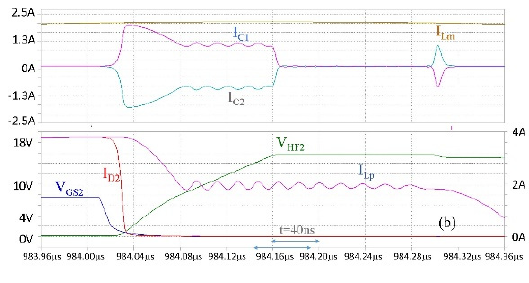
Figure 16. Simulation results in steady state of the turn ‐ off ZVS of device Q 2 . In the up plot there are the magnetizing current I Lm , the capacitors current I C1 and I C2 . In the bottom plot there are the gate voltage of Q 2 (V GS2 ), the V HF2 voltage, the current on the primary side (I Lp ) the drain current of the MOSFET Q 2 (I D2 ), time t = 40 ns/div. ( a ) Low load. ( b ) High load. From inequality 7, it is possible to evaluate the capacitor value across the